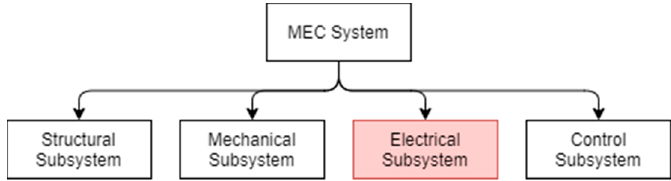
Figure 1. Illustration of static Bayesian Network (BN).